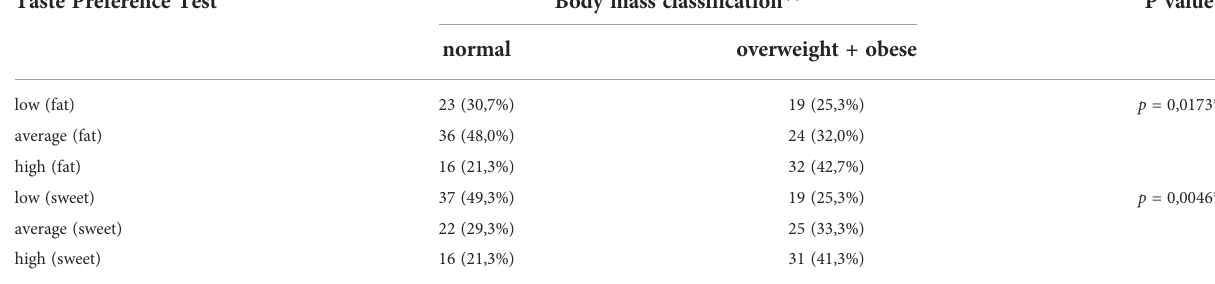
TABLE 3 Relationship between taste preferences and body weight category among